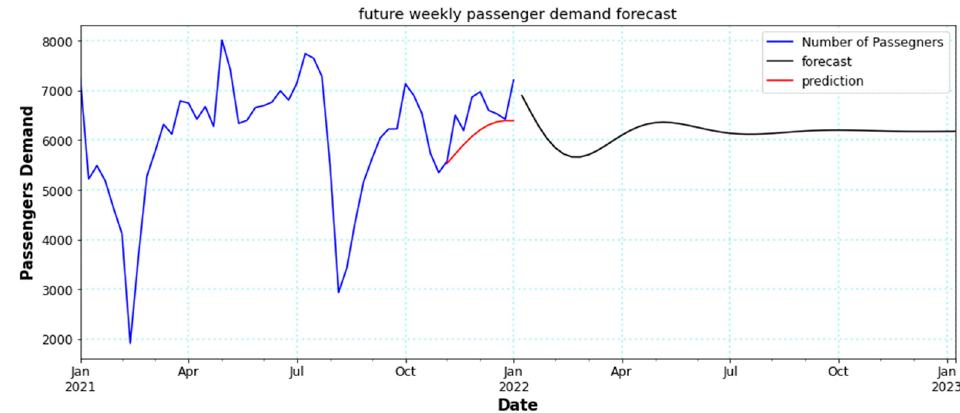
Figure 15. Weekly passenger demand plot with forecasted values using the Box–Jenkins model. Table 2. Parameters of daily and weekly time series model for the Box–Jenkins.